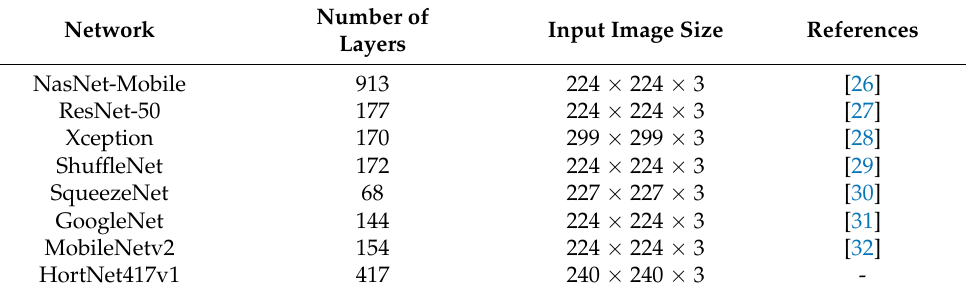
Table 2. Network for comparative